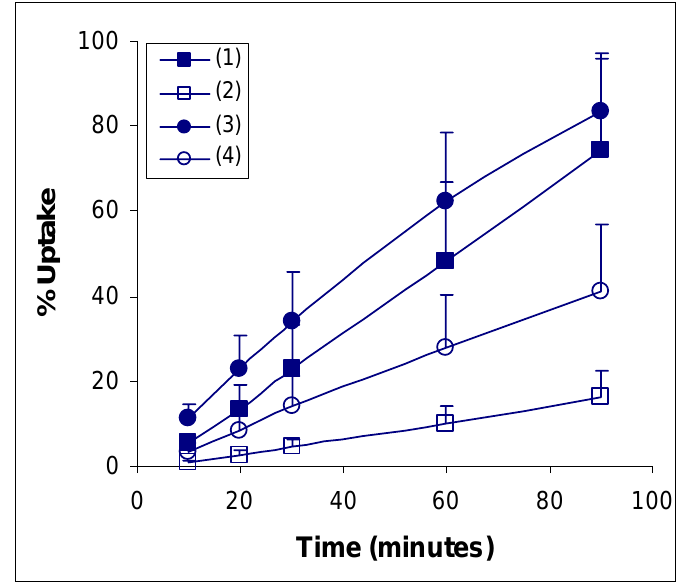
Figure 5: Echinacea alkylamide transport kinetics in Caco-2 monolayers. (cid:132) (2 E ,4 E ,8 Z ,10 Z )- N -isobutyldodeca-2,4,8,10-tetraenamide mw = 247 ( 1 ); (cid:133) (2 E ,4 E ,8 Z )- N -isobutyldodeca-2,4,8-trienamide mw = 249 ( 2 ); (cid:122) (2 E )- N - isobutylundeca-2-ene-8,10-diynamide methylbutyl)dodeca-2-ene-8,10-diynamide mw = 259 ( 4 ). Values are means ± sd for 5